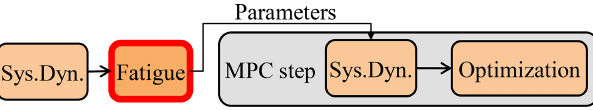
Figure 2. Externalization of fatigue estimation (Rainflow algo- rithm) from the